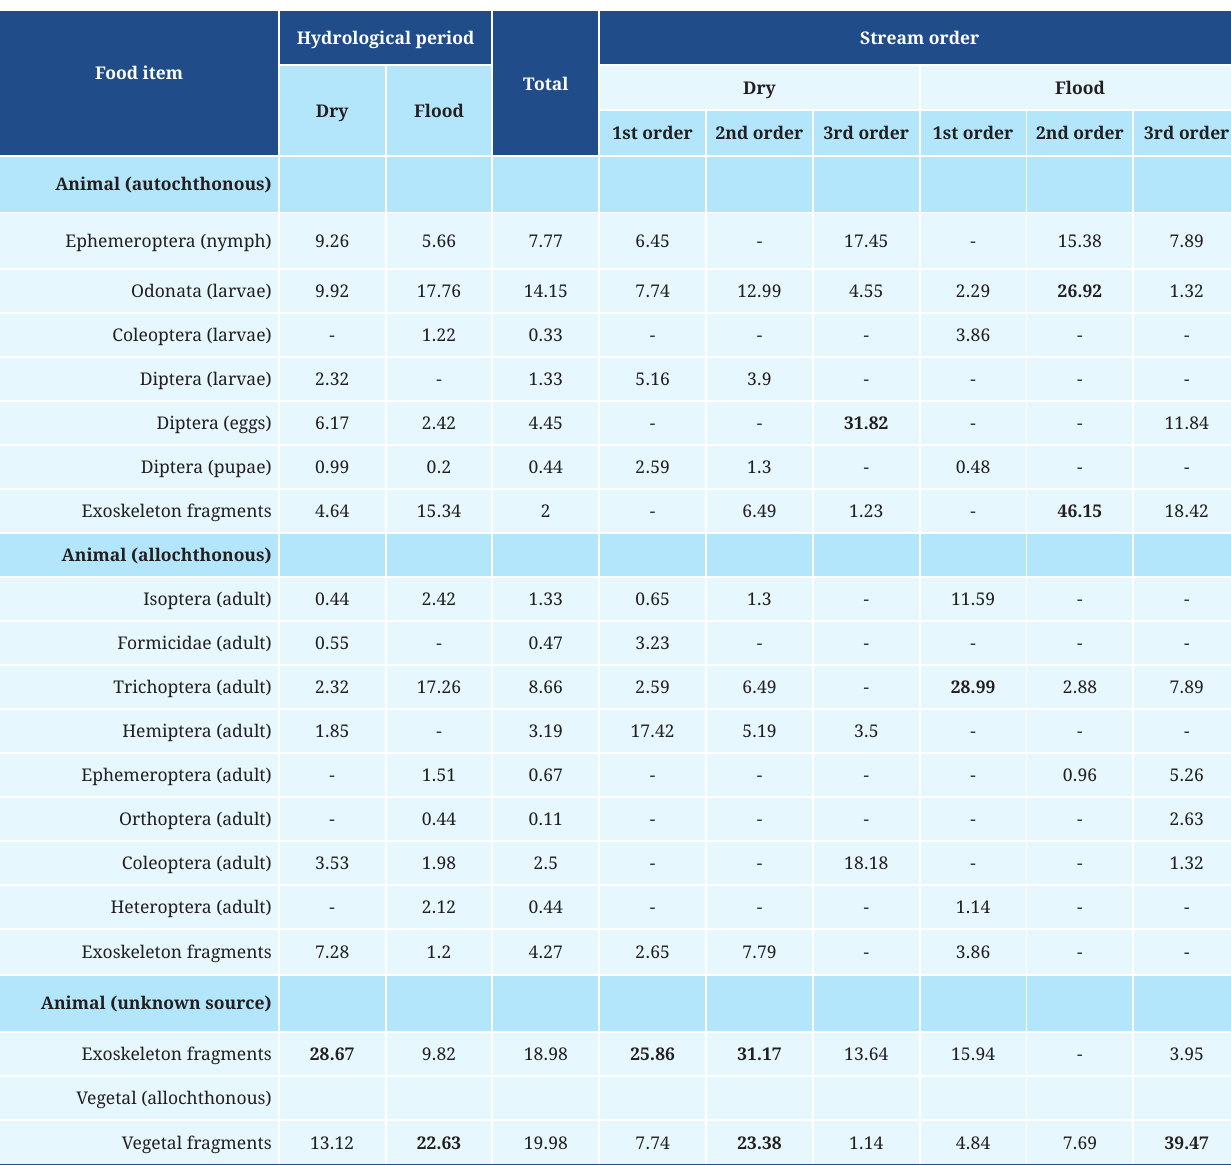
TABLE 1 | Alimentary index (Ai%) per hydrological period and stream order for Hyphessobrycon heterorhabdus . Bold values indicate items with a strong contribution to diet (≥